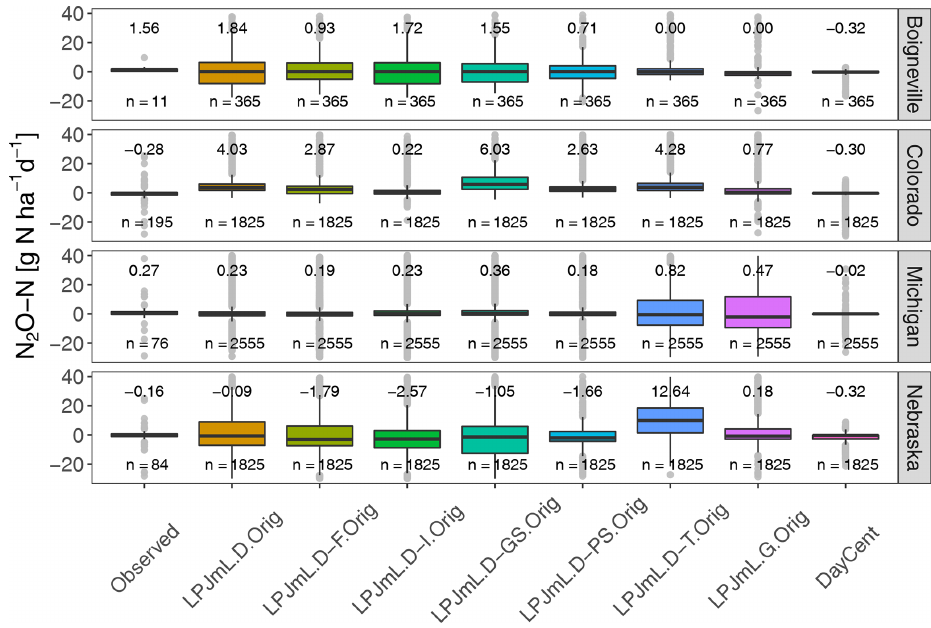
Figure A1. Effects of no-tillage (i.e., the difference between no-tillage and tillage) on N 2 O emissions on individual days by the different experimental simulations, including the original runs of LPJmL, observations and the simulated values by DayCent. The numbers on top of the box plots represent the median values.